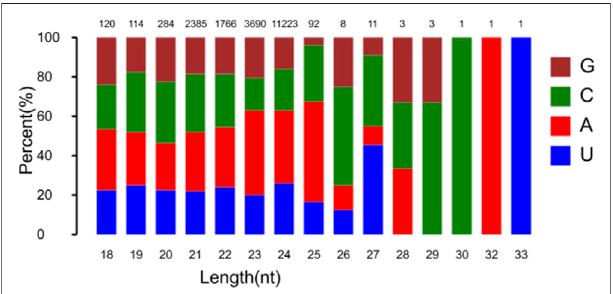
FIGURE1| Lengthdistribution ofpredictedsiRNAsin fl oweringChinese cabbage. Statistics of fi rst base of all kinds of predicted siRNAs is shown. X -axis is length of siRNA in bp; numbers on top are mean numbers of predicted siRNAs.